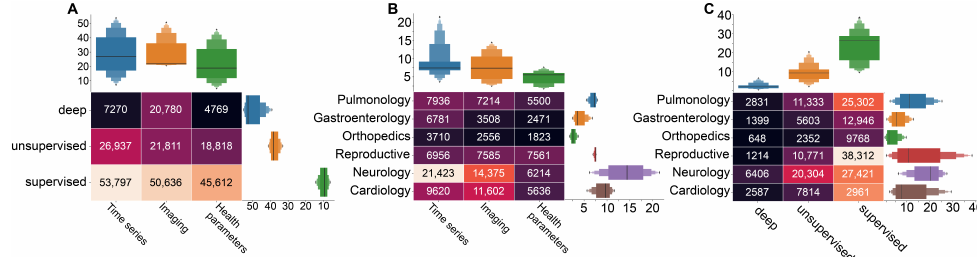
Figure 5. Results of query research of the PubMed database with the number of papers acquired via the corresponding search queries. ( A ) the use of machine learning types in combination with different medical data types; ( B ) medical data in artificial intelligence research in different medical areas; and ( C ) the use of machine learning methods in different medical